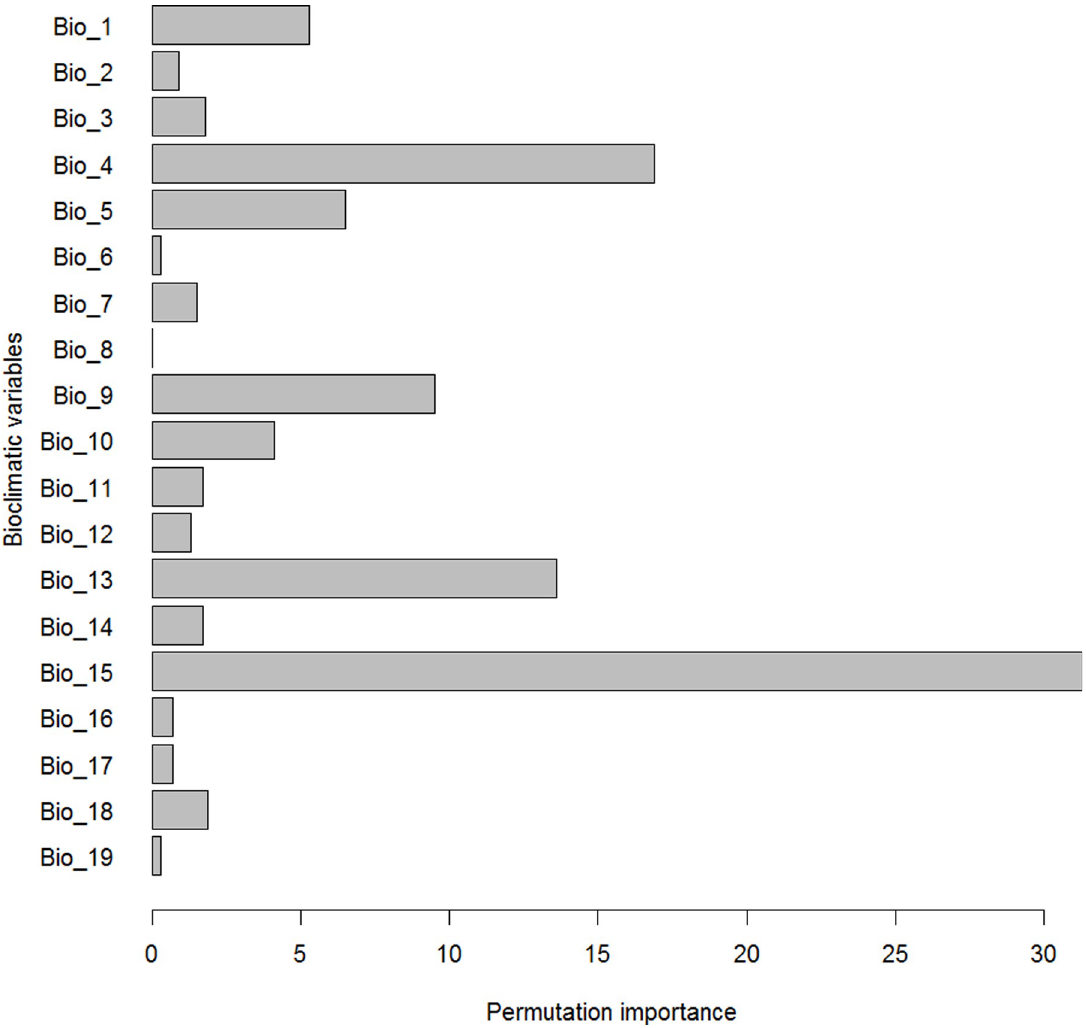
Fig 6. Relative importance of variables in bioclimatic niche